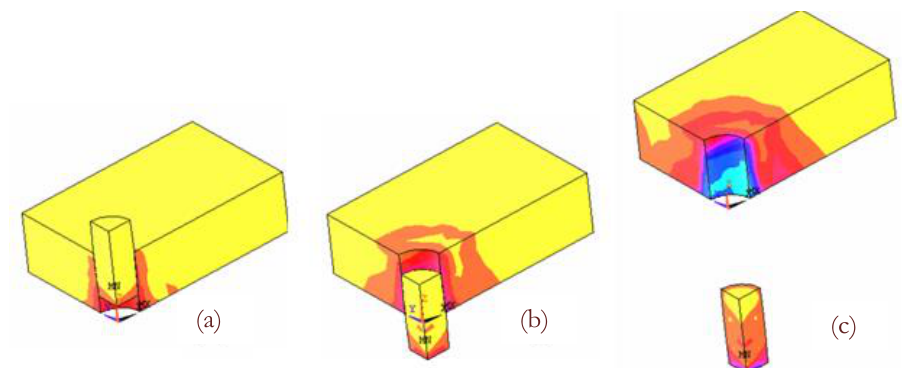
Figure 6: Distribution of Von-Mises equivalent stress around the hole.